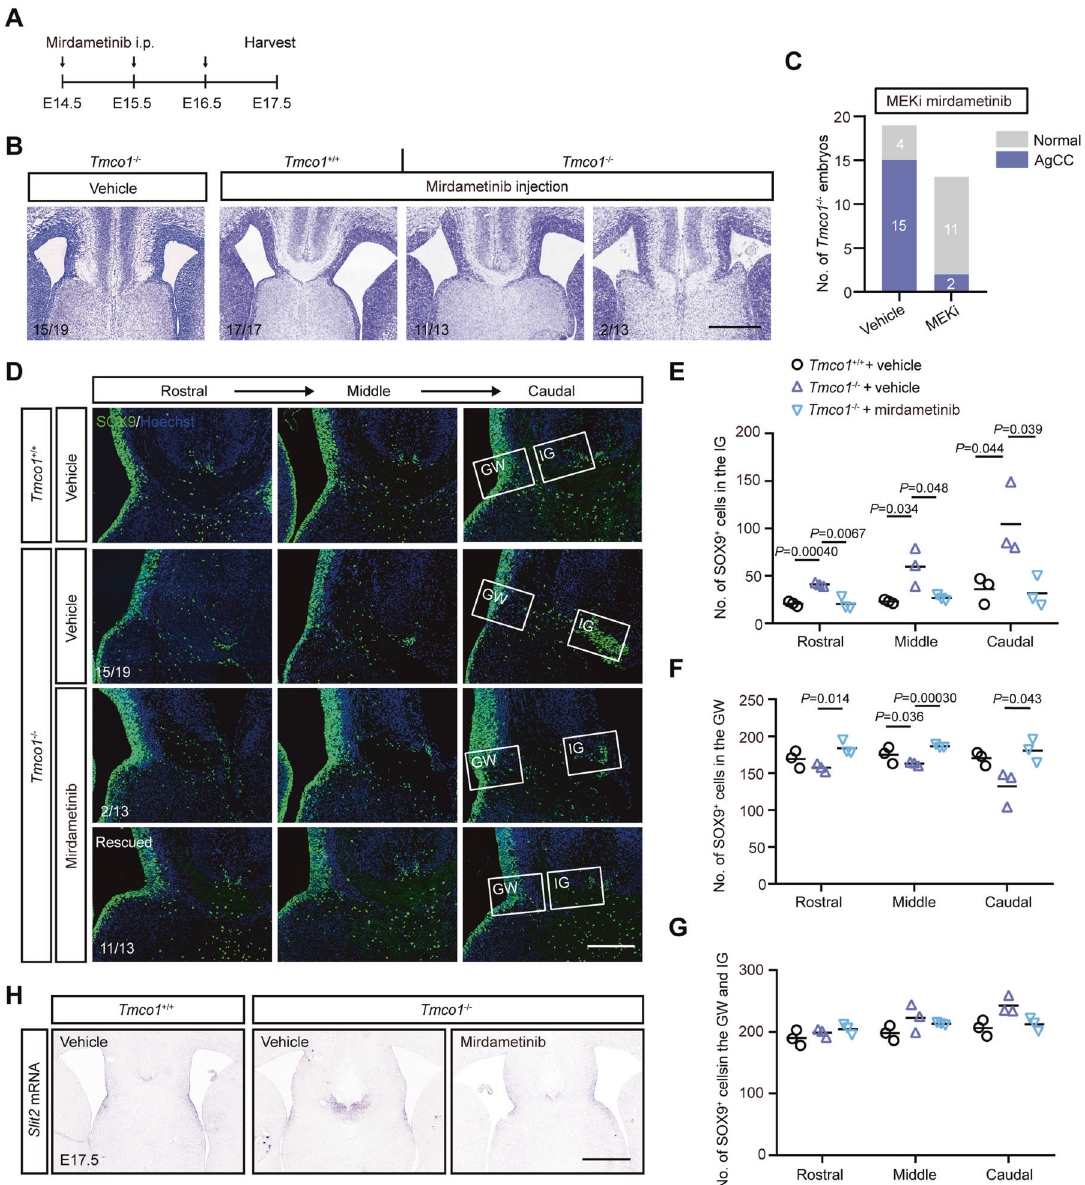
Fig. 5 The phenotype of AgCC can be ef fi ciently relieved by MEK inhibitor - mirdametinib. A The timeline of mirdametinib injection, which was administrated to pregnant females daily between E14.5 and E16.5 spanning the period of CC formation and harvested at E17.5. B Nissl staining of the coronal sections in the Tmco1 + / + and Tmco1 − / − treated with/without mirdametinib. Numbers at the bottom left indicate the proportions of embryonic brains with phenotype shown in that panel. Scale bar, 500 μ m. C Quanti fi cation of the number of Tmco1 − / − embryos showing normal or AgCC phenotypes with/without mirdametinib treatment (i.p., 3.0 mg/kg). Vehicle-injected pregnant females, n = 12; mirdametinib-injected pregnant females, n = 10. D SOX9 immuno fl uorescence (green) at the telencephalic midline in Tmco1 + / + and Tmco1 − / − E17.5 embryos treated with/without mirdametinib in rostral, middle and caudal coronal sections through the developing CC region. Numbers at the bottom left indicate the proportions of embryos with phenotype shown in that panel. Scale bar, 200 μ m. E – G The counts of SOX9-positive cells in the GW ( E ), IG ( F ) and GW + IG ( G ). The vehicle group: Tmco1 + / + , n = 3; Tmco1 − / − , n = 3; the mirdametinib-treated group: Tmco1 − / − , n = 3 (2/3 rescued and 1/3 not fully recovered). One-way ANOVA with Tukey ’ s correction for multiple comparisons. H In situ hybridization for the expression of Slit2 in the IG of coronal sections from E17.5 Tmco1 + / + and Tmco1 − / − embryos treated with/without mirdametinib. Scale bar, 500 μ m. See also Fig. into 150 μ m on vibratome. Sections were stained with Hoechst 33342 PAGE and followed by incubation with primary antibodies for 1h at room diluted 1/1 000 in PBS, then mounted with mounting medium and kept at temperature and 4°C overnight. Then, secondary antibodies conjugated with 4 °C until the microscopic analysis. horseradish peroxidase were added and incubated for 1h. The bands were visualized by Chemiluminescence (Millipore, Billerica, MA, USA). Western-blotting assay RNA extraction and Quantitative real-time PCR Tissues or cells were lysed in RIPA buffer with 1mM PMSF, 50mM DTT, 1mM Total RNAs from E15.5 or E16.5 telencephalons were extracted by using EDTA, 1mM NaF and protease inhibitor cocktail (Roche, 4693159001, Basel, Trizol Reagent (Invitrogen, 15596026, Carlsbad, CA, USA). RNA (1 μ g) was Switzerland). After centrifuge, the protein extractions were separated by SDS-